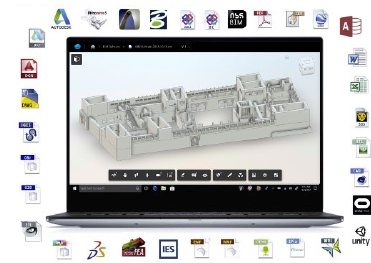
Figure 9. The fourth step: A360 allows information sharing via the cloud. Non-expert users can display HBIM models, data and documentation without having advanced BIM